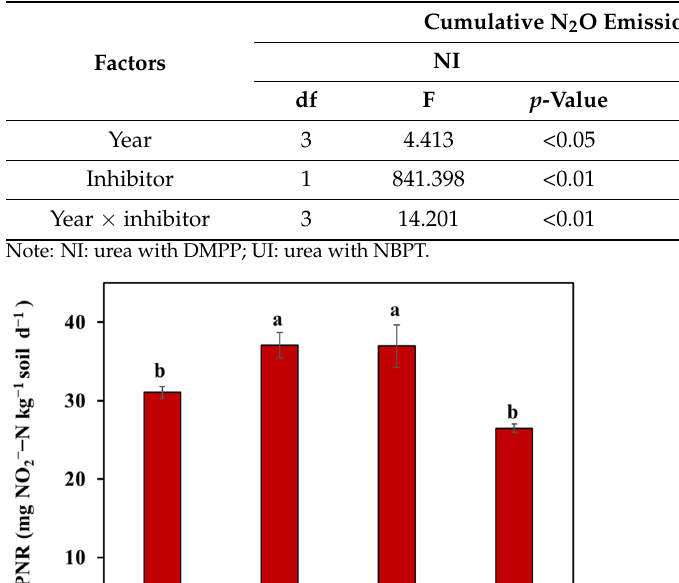
Table 2. Two-way ANOVA analysis for the effects of year and N stabilizer on cumulative N 2 O emissions.